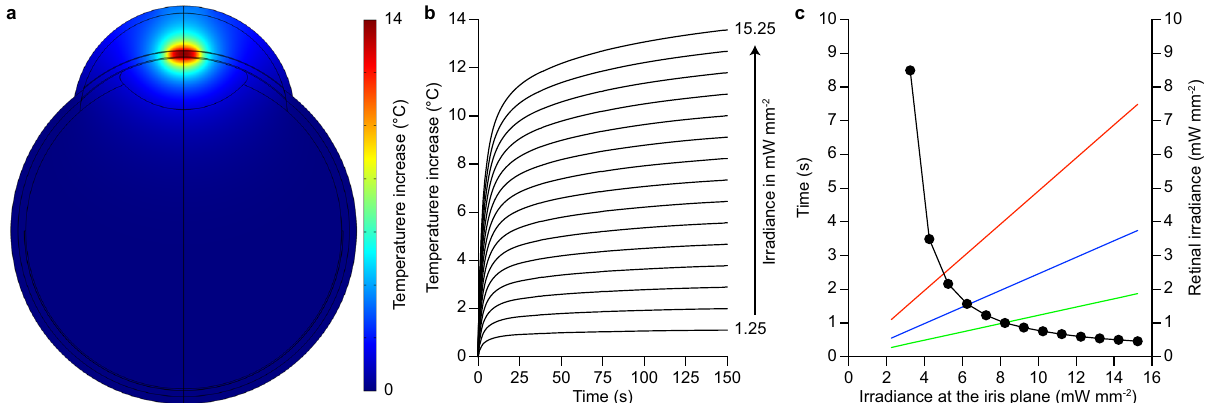
Fig. 10 Thermal simulations at the iris plane. a Temperature increase in the modelled eye after 150 s of continuous illumination on the iris at the MPE (565 nm, 15.25 mWmm − 2 ). b Quanti fi cation of the temperature increases at the iris plane during 150 s of continuous illumination for increasing irradiance levels from 1.25 to 15.25 mWmm − 2 (increments of 1 mWmm − 2 ). c Quanti fi cation of the time to reach a thermal increase of 2 °C (left axis) as a function of the irradiance at the iris plane for continuous illumination at 565 nm (black circles and line). The coloured lines show the irradiance obtained at the retinal level (right axis) for ten pulses repeated at 5 Hz (red line), 10 Hz (blue line) and 20 Hz (green line) as a function of the irradiance at the iris plane for continuous